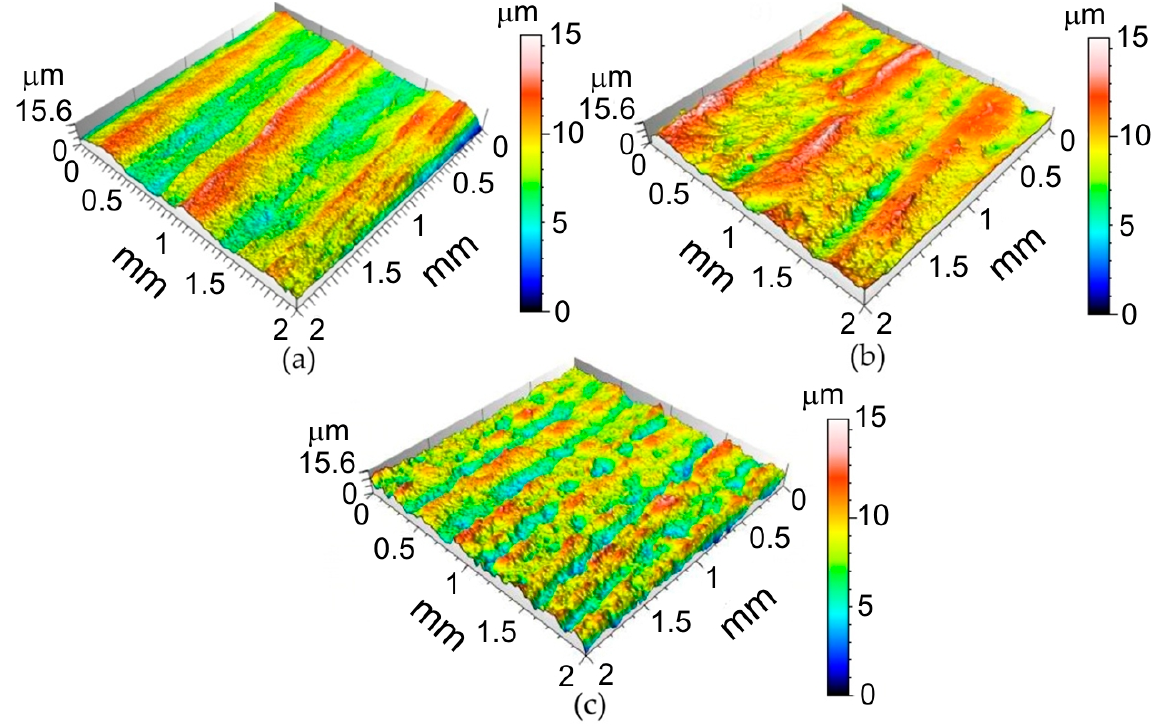
Figure 4. Surface topographies of the inner surface of ribs formed in 1-mm-thick EN AW-2024-T3 fabricated with the following conditions: ( a ) a p = 0.4 mm, v = 18 rpm; ( b ) a p = 0.4 mm, v = 202 rpm; ( c ) a p = 0.2 mm, v = 202 rpm.